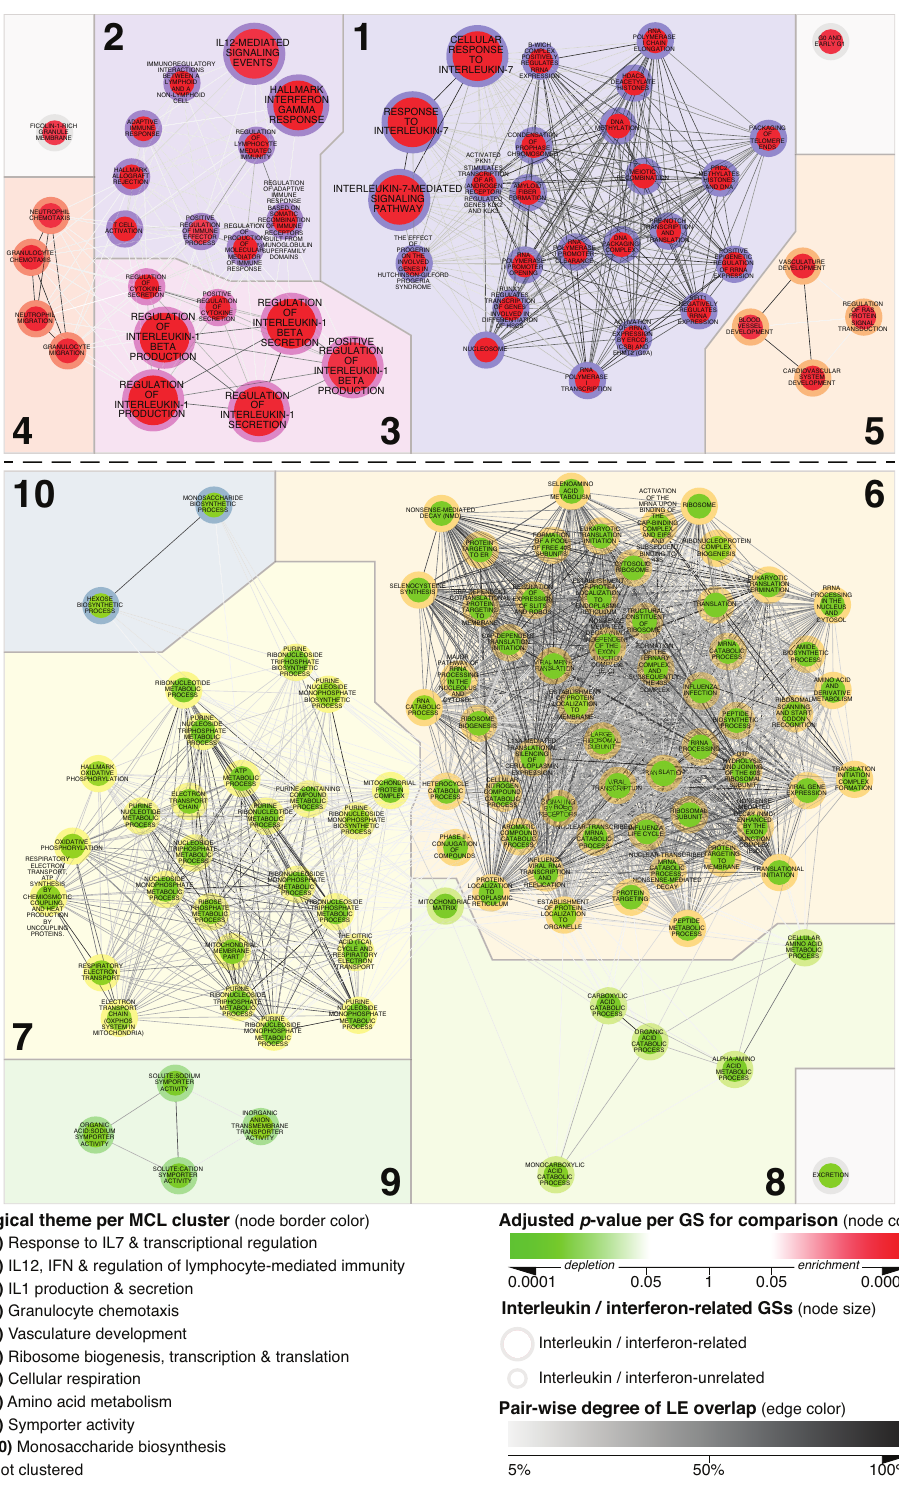
Figure 1. MCD’s glomerular transcriptional landscape delineating contextualized alterations in gene expression between MCD and N_CTRL. Any GS passing the significance thresholds of adjusted p < 0.001 and with at least 33.34% of its member genes comprised in its leading edge (LE) when comparing MCD vs. N_CTRL was mapped as a node within the basic network. Onto this scaffold, the parameters listed in the legend for the comparison of MCD vs. N_CTRL were mapped. By keeping all mapping parameters constant, this figure is directly comparable with Figures 2 and